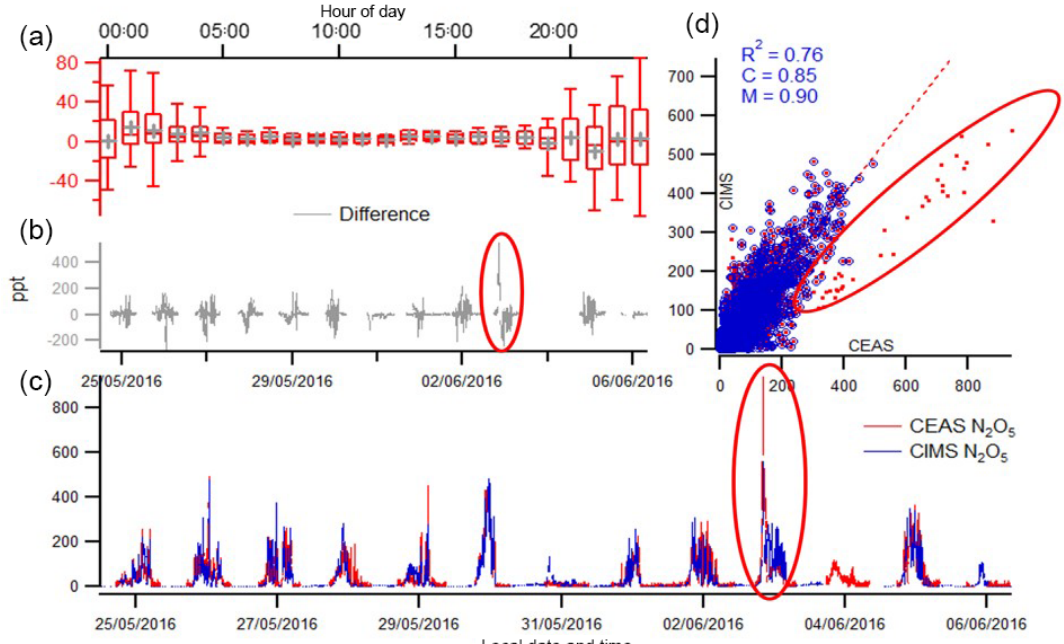
Figure 2. CIMS and cavity enhanced absorption spectrometer (CEAS) 1min averaged data of N 2 O 5 with corresponding correlation plot (a) , campaign and diurnal deviation (panels b and c , respectively). The red highlighted periods represent data collected on 3 June where a different correlation gradient was observed between CIMS and CEAS. The box-and-whisker plot represents the diurnal difference for the campaign between the CEAS and CIMS measurements (d) . Panel (c) shows the y intercept of the line of best fit and M is the